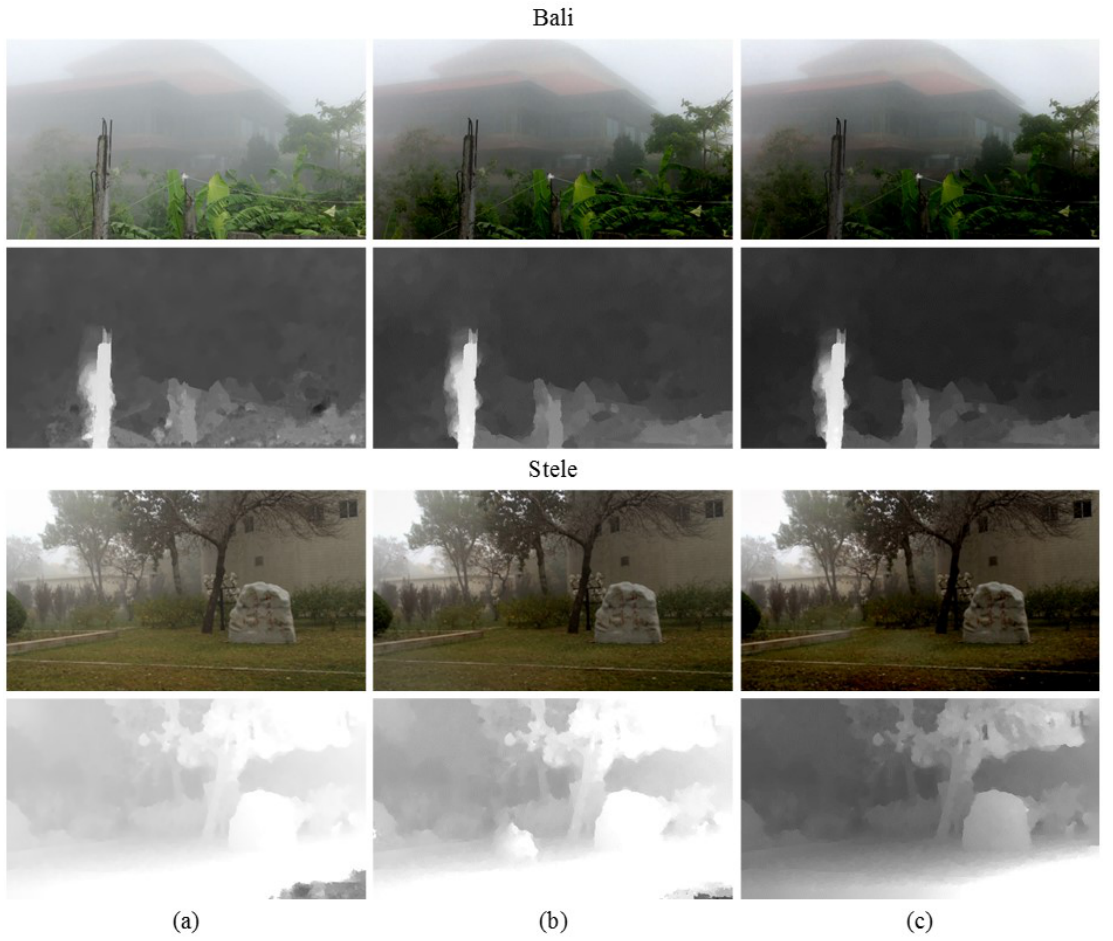
Figure 6. Defogging results using real-world videos from [31]. ( a ) Input foggy images; ( b ) defogged results after three iterations; and ( c ) defogged results after five iterations. Corresponding transmission maps are shown below each